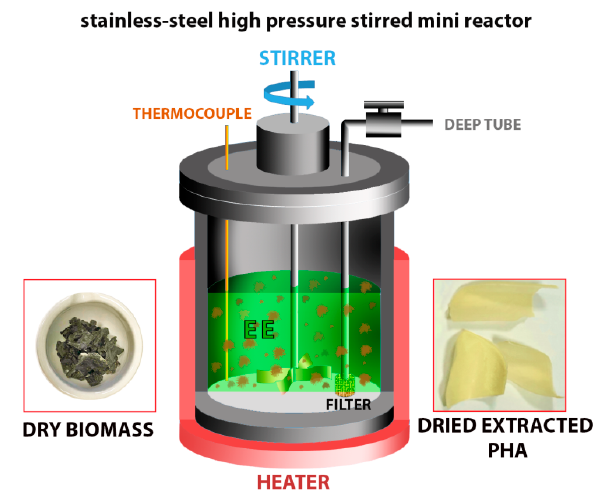
Figure 1. Scheme of the employed stainless-steel high pressure stirred mini reactor, original dry biomass and dried extracted PHA.